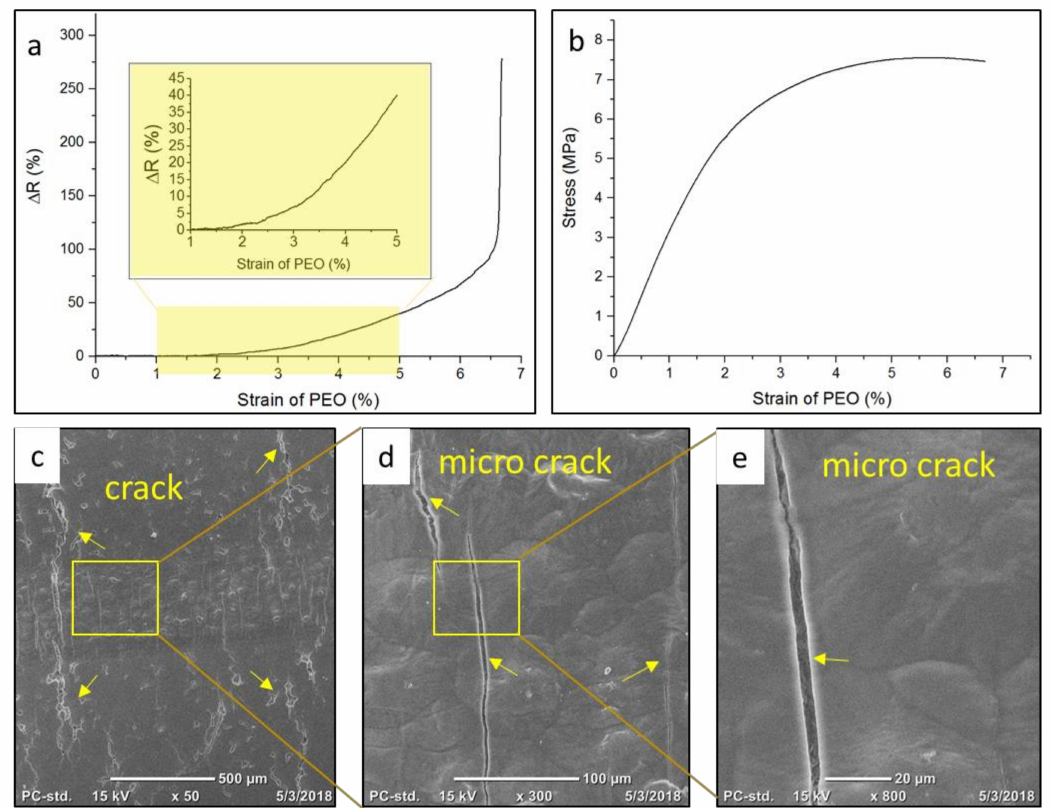
Figure 2. ( a ) Relative resistance changed as function of static strain; ( b ) stress–stain curve of polyethylene oxide (PEO) substrate; ( c – e ) SEM image of electrode after being stretched for 7%. Cracks and microcracks marked by yellow